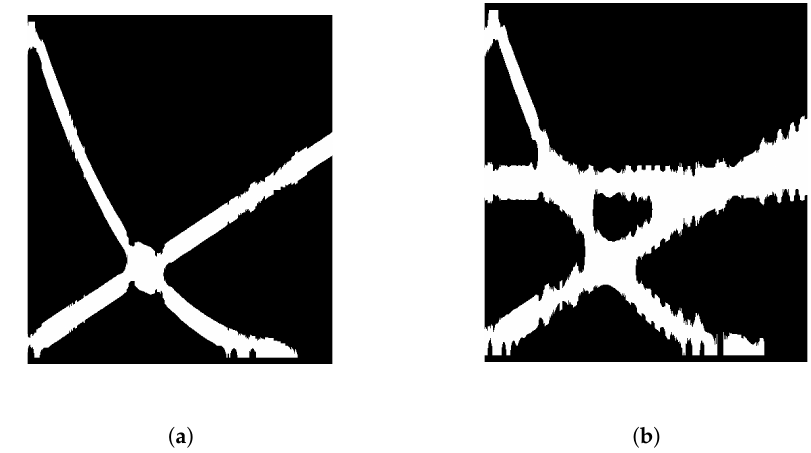
Figure 7. ( a ) Binary map in Figure 2b with removed black holes. ( b ) Binary map in Figure 6b with removed black